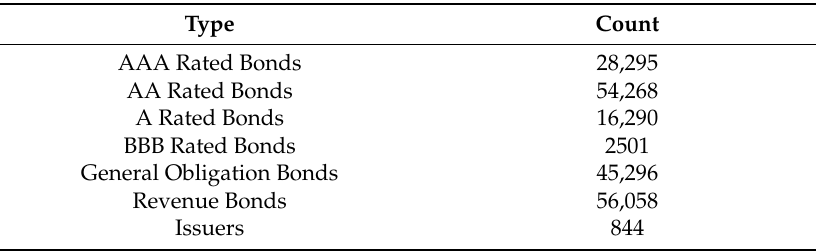
Table 3. Summary of bonds used for evaluation.